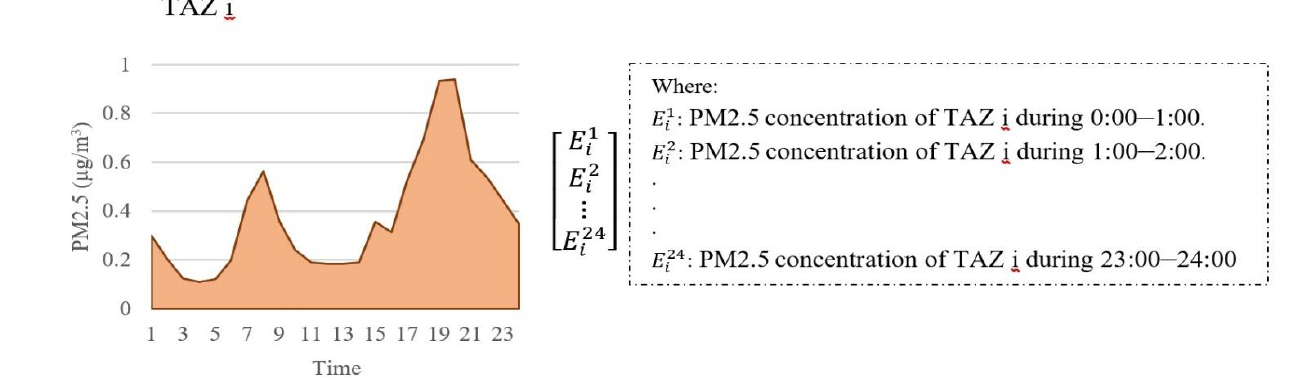
Figure 4. Average hourly PM2.5 concentration over TAZs .